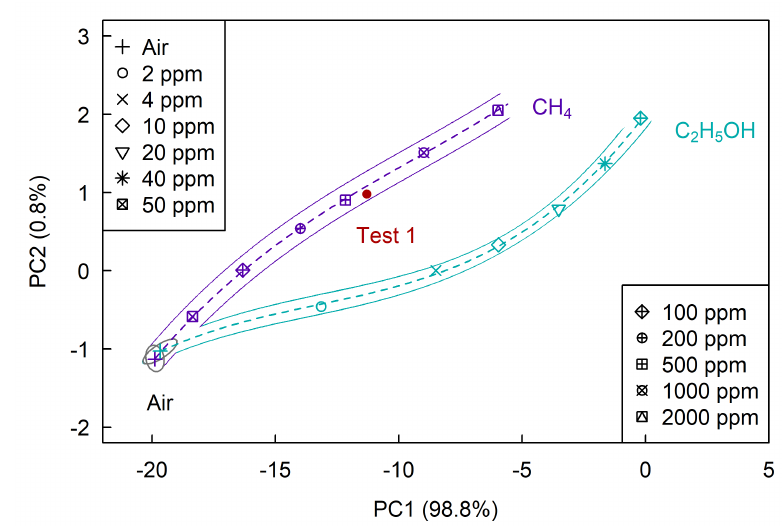
Figure 9. The (PC1, PC2) plane at the determination of CH 4 and C 2 H 5 OH.